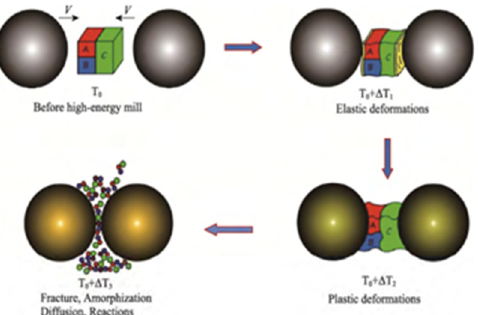
Figure 4. Schematic diagram of mechanochemical effects in the ball milling process. Figure 3. Schematic diagram of mechanochemical effects in the ball milling process. Reprinted from ref.